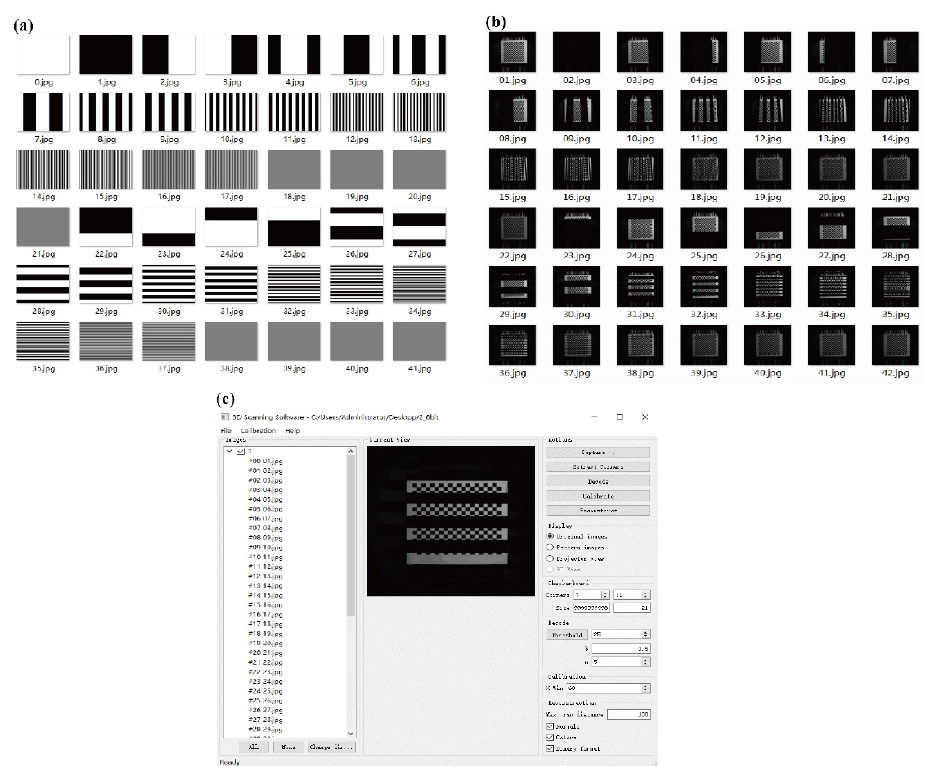
Figure 4. Gray code patterns: ( a ) generated gray code pattern; ( b ) captured image; ( c ) projector calibration software.